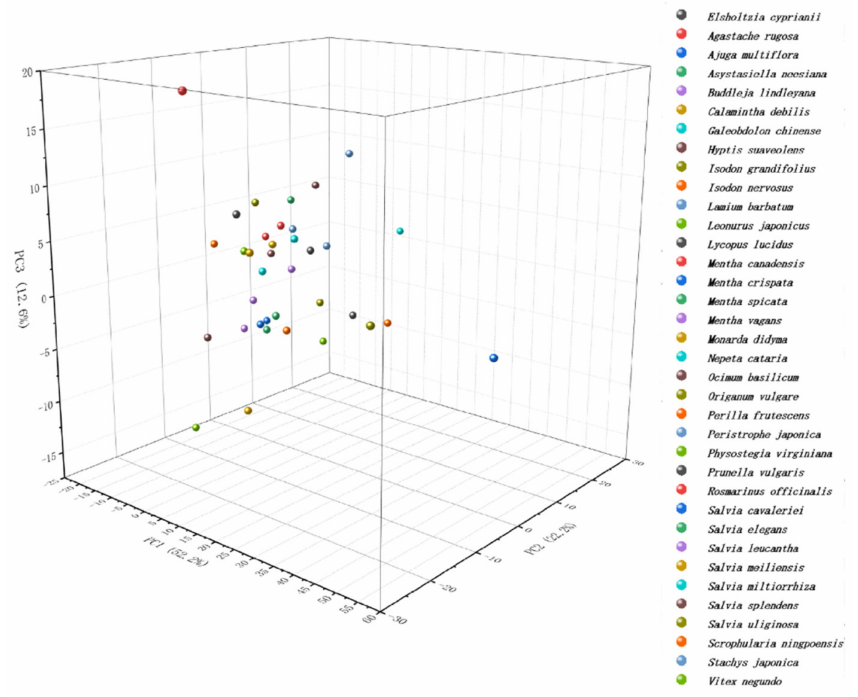
Figure 6. PCA analysis of 31 species from 22 genera in the family Lamiaceae and 5 exotaxa in this